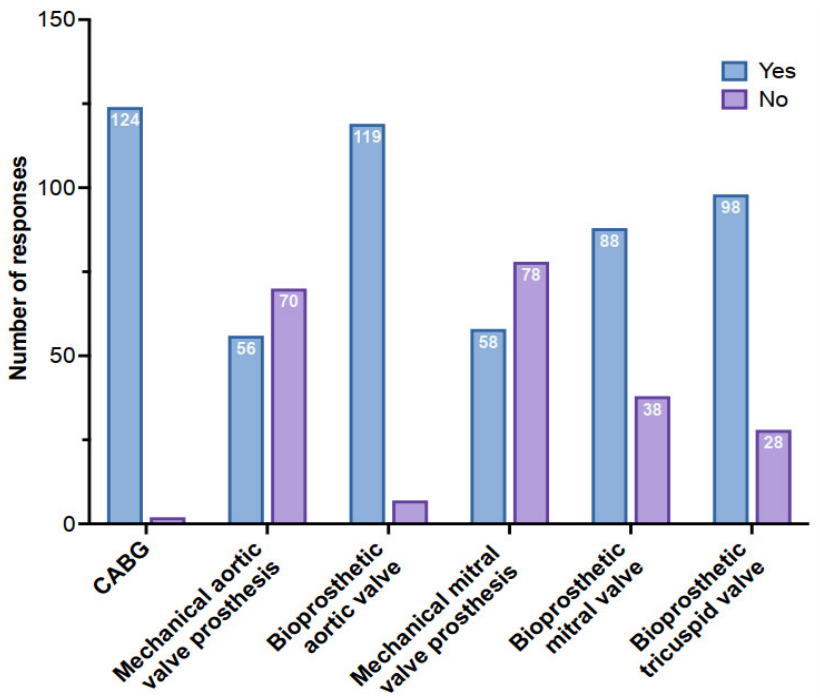
Figure 1. Number of respondents using low-molecular-weight heparin according to the type of cardiac surgery. CABG: coronary artery bypass graft.